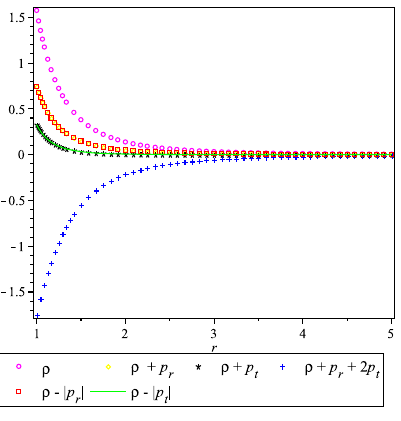
Fig. 1 Plots of EC terms for 15 subcases of model I: